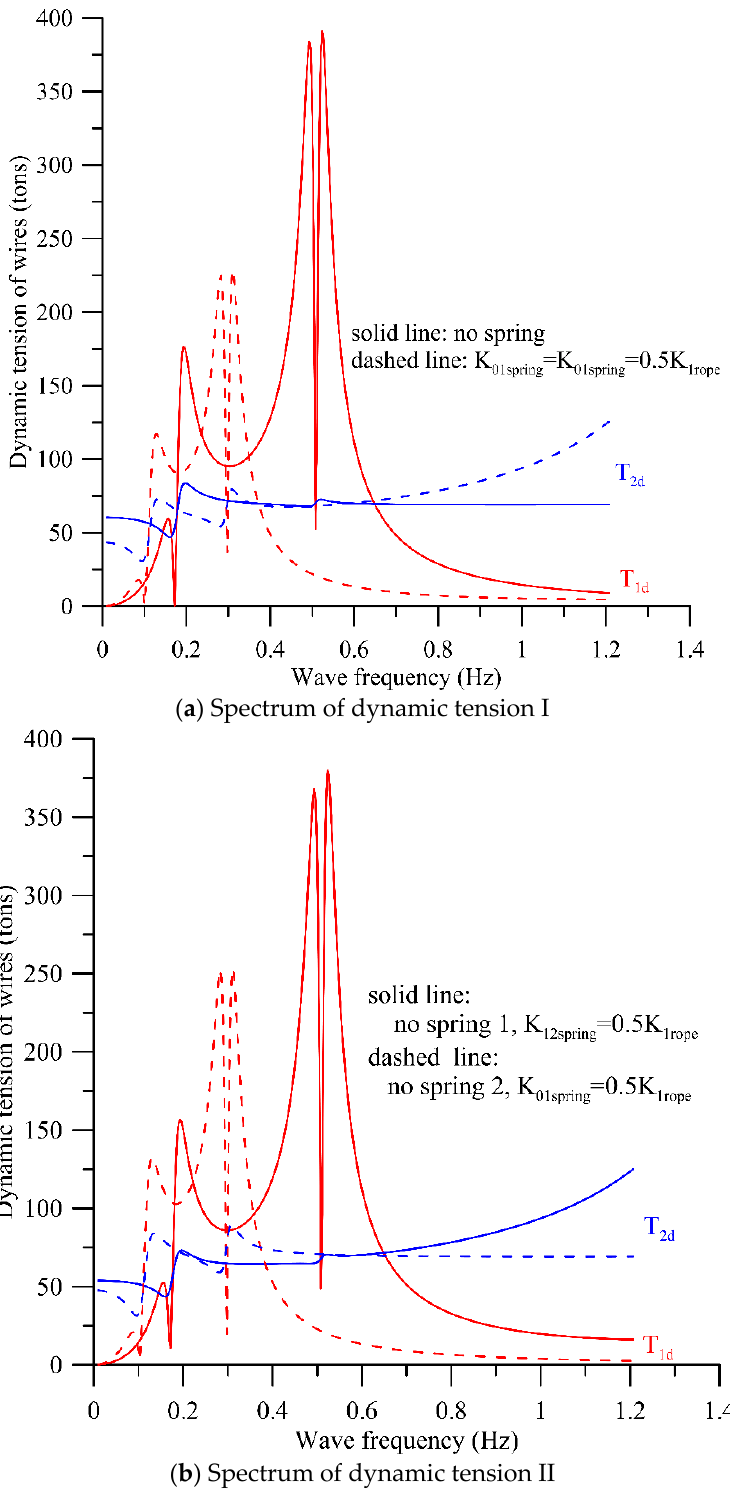
Figure 7. Effects of the buffer spring connecting to the ropes and the wave frequency f on the dynamic tensions of rope, { T 1 d , T 2 d } . [ A BB = 7 m 2 , θ 1 = 40 ◦ , m ef f , x = 6.038 tons, m ef f , y = 9.714 tons, L 1 = 1929.1 m, other parameters are the same as those in Figure